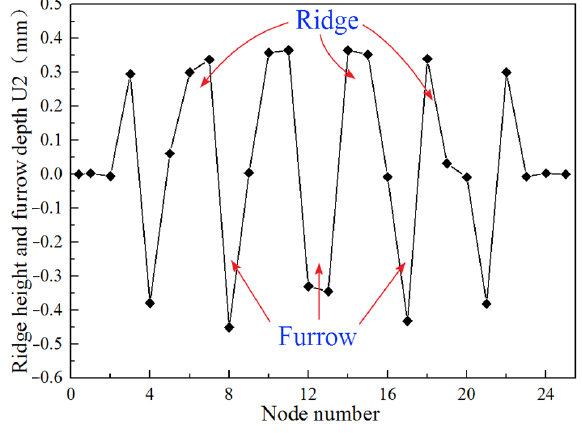
Figure 9. Convex ridges height and furrow depth of whole-tooth furrow.